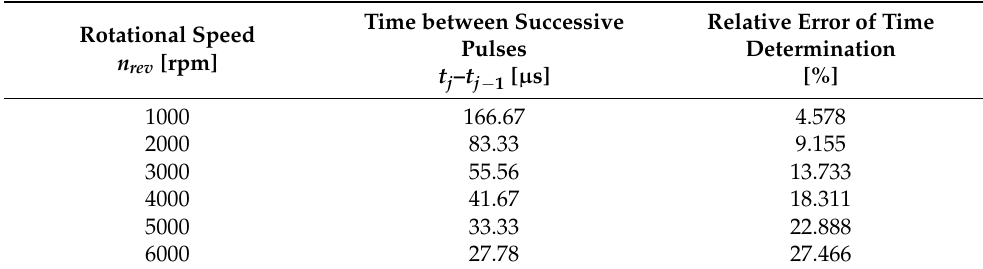
Table 2. Values of relative errors in determining time between successive pulses for the sensor of the crankshaft position.